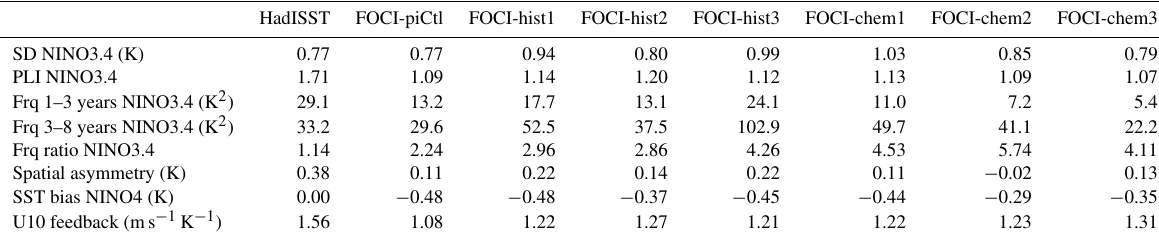
Table A1. ENSO properties in observations (HadISST, Rayner et al., 2003; ERA-Interim, Dee et al., 2011) and the individual FOCI experi- ments. In the first row, the standard deviation (SD) of NINO3.4 SST is shown; in the second row, the phase-locking index (PLI) of NINO3.4 SST as defined in Bellenger et al. (2014) as the SD of NINO3.4 of December, January and February divided by the SD of NINO3.4 of April, May and June; in the third row, the variability of the NINO3.4 SST on a frequency band of 1–3 years; in the fourth row, the variability of the NINO3.4 SST on a frequency band of 3–8 years; in the fifth row, the ratio of row 4 to row 3; in the sixth row, the spatial asymmetry between El Niño and La Niña as shown in Fig. 22c, f; in the seventh row, the SST bias in the NINO4 region relative to HadISST; in the eighth row, the zonal wind–SST feedback in NINO4, calculated by regression of U10 anomalies of NINO4 onto SST anomalies of NINO3.4.